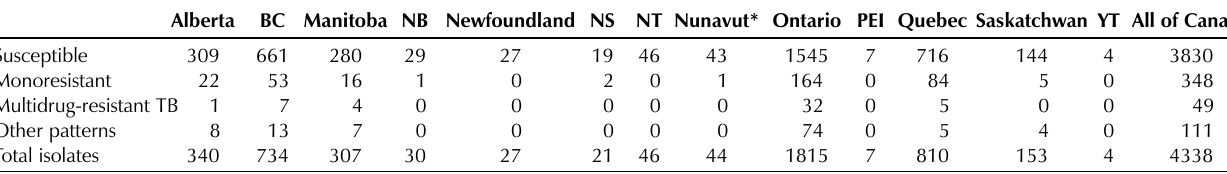
Multidrug-resistant tuberculosis is defined as resistance to at least isoniazid and rifampin; *Because streptomycin and pyrazinamide are not part of the routine first-line drugs in some provinces and territories, denominators for any resistance to these drugs have been modified to reflect this (1998: strep-